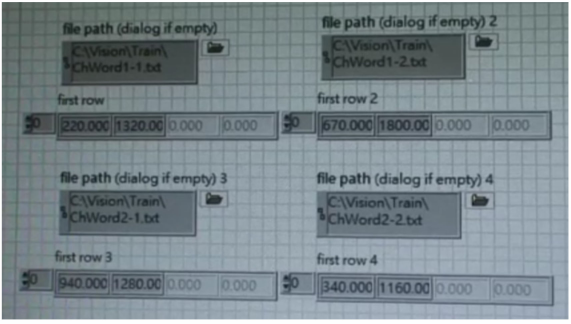
Figure 22. The latest coordinate information.